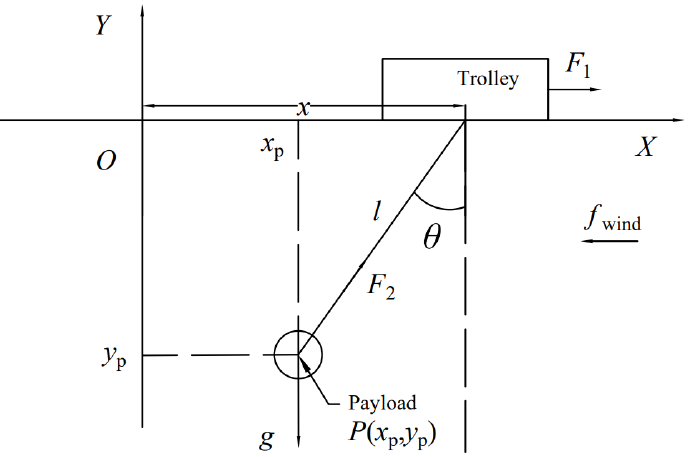
Figure 1. 2D overhead crane model.